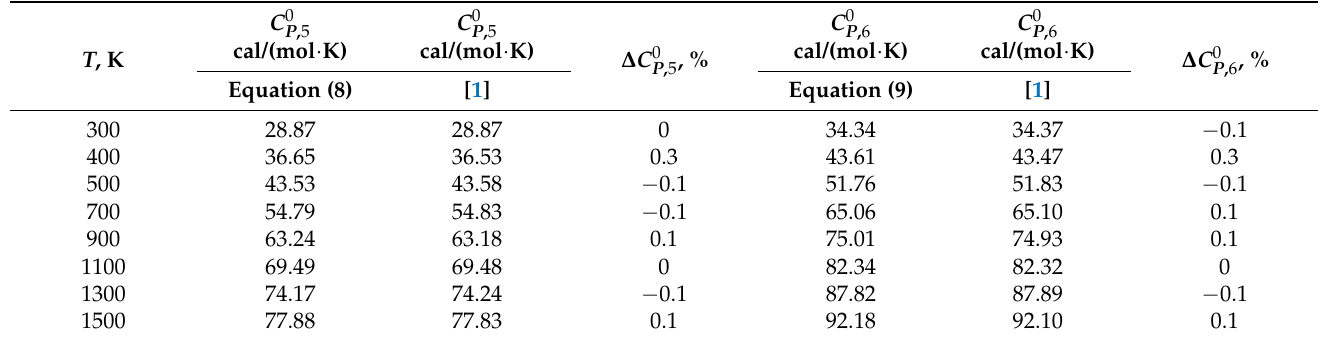
( T ) of n -C 5 H 12 and n -C 6 H 14 . P